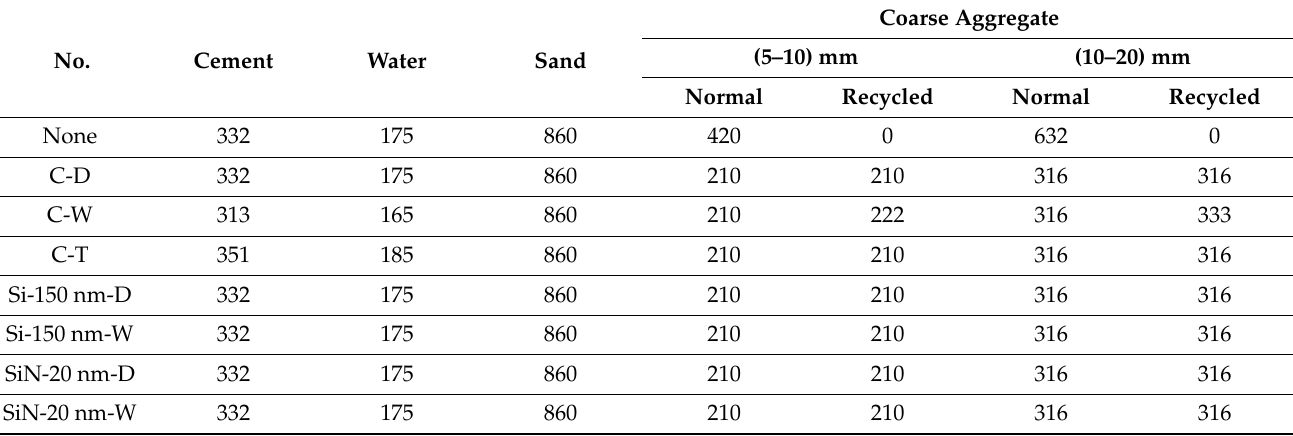
Table 9. Mix proportions of concrete with different aggregates (kg/m 3 ).